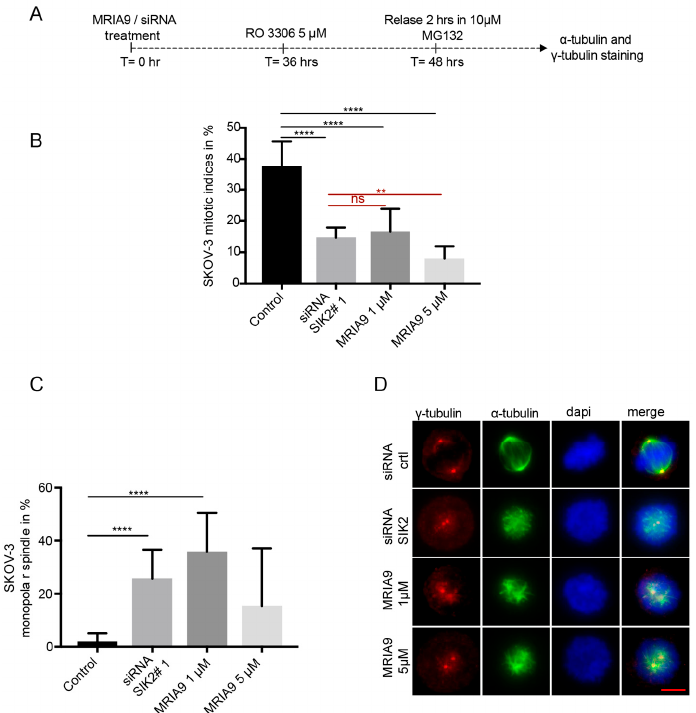
Figure 2. MRIA9 impedes G2-M transition and causes spindle assembly errors in SKOV-3 cells. ( A ) Scheme of the experimental procedure. SKOV-3 cells were treated with siRNA SIK2#1 or 1 µ M and 5 µ M MRIA9 for 36 h. Cells were then synchronized into the G2-phase using 5 µ M RO3306 for 12 h. The synchronized cells were released for 2 h into mitosis in the presence of 10 µ M